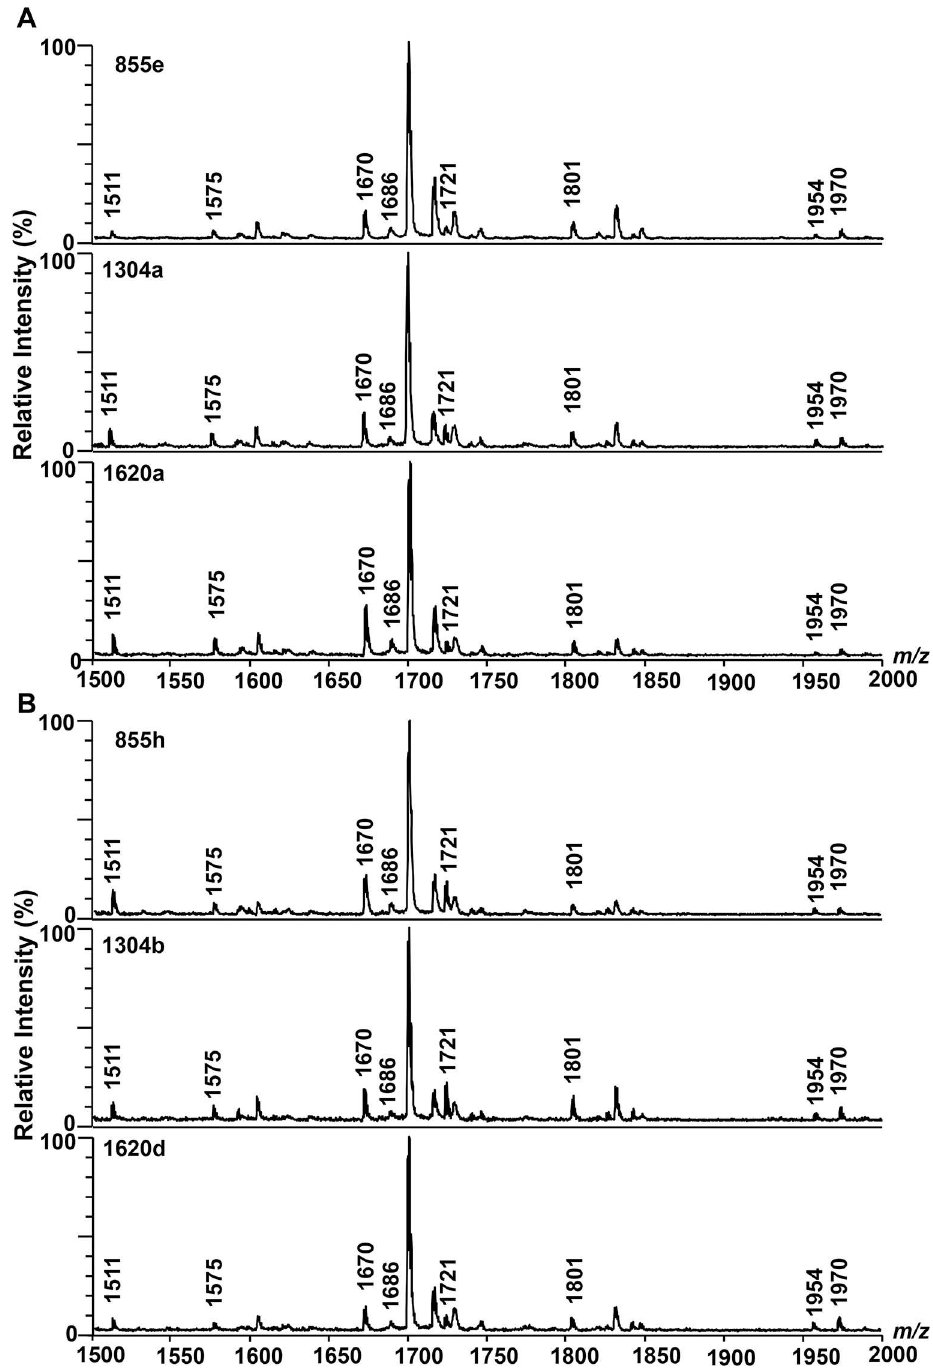
Fig 4. MALDI-TOF lipid A spectra of clinical isolates of B . pseudomallei strains from three Thai patients with primary infection followed by an episode of relapse. (A) Primary isolates: 855e, 1304a and 1620a. (B) Relapse isolates: 855h, 1304b and